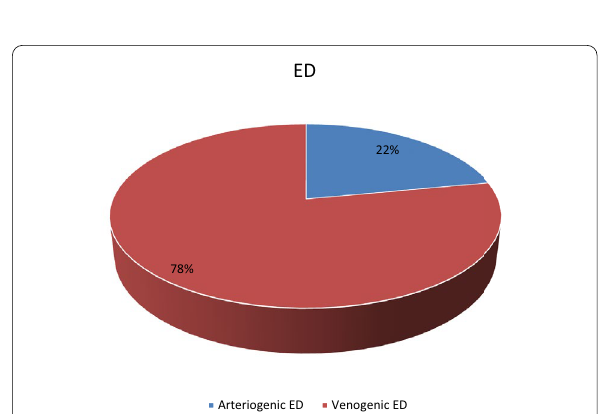
Fig. 3 Pie chart showing the pattern of Doppler findings among patients with vasogenic erectile